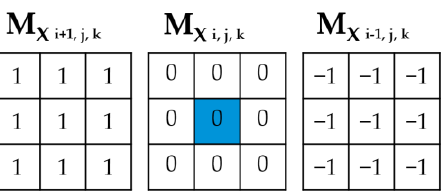
Figure 8. Masks that are used to approximate the gradient across the x-plane. These masks are akin to the 2D Prewitt masks for image processing.